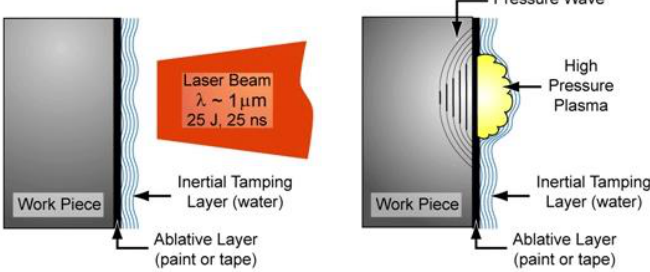
Figure 4. Schematic view of the LSP process showing the workpiece, ablative layer, inertial tamping layer, and laser input.